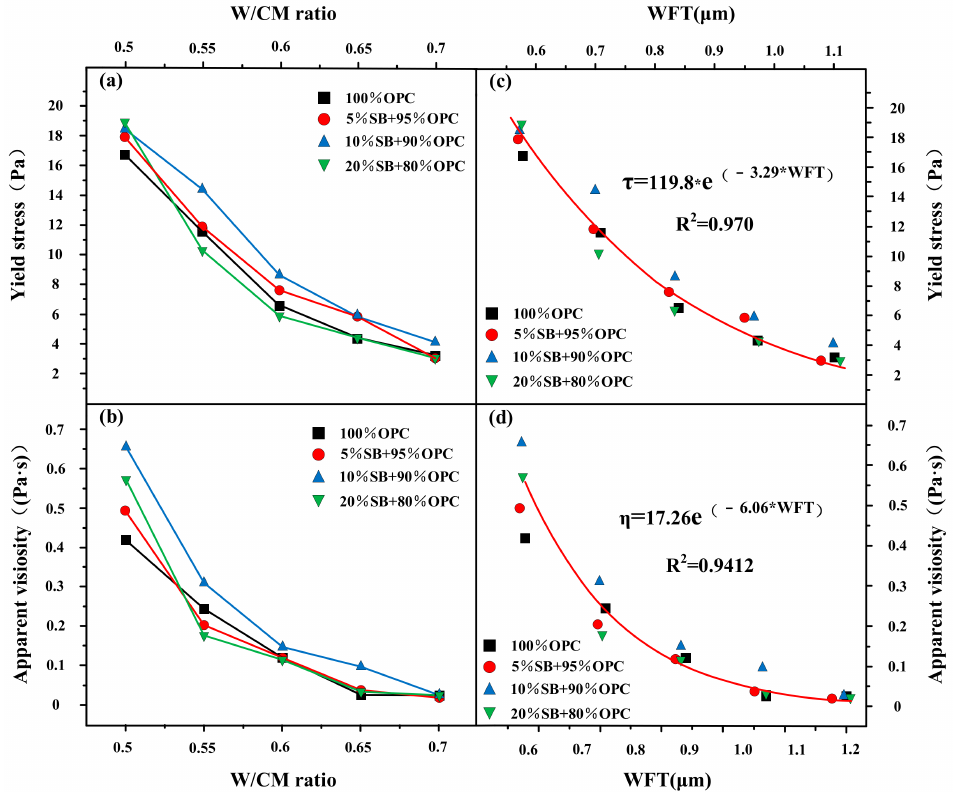
Figure 6. Yield stress and apparent viscosity versus W/CM ratio ( a , b ) and WFT ( c , d ). The apparent viscosity and yield stress are shown as functions of the WFT in Figure